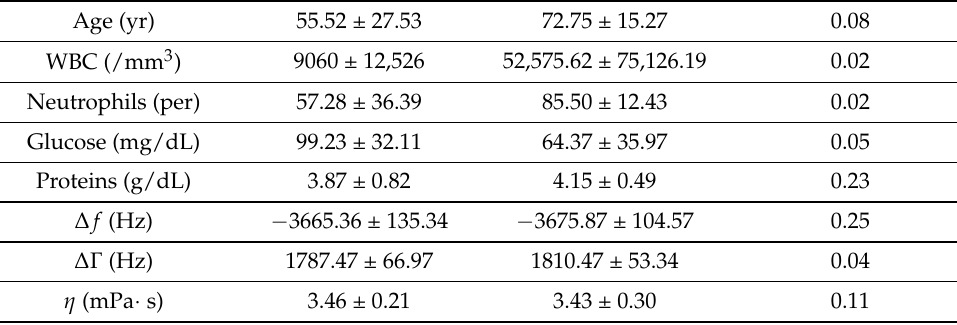
Table 3. Comparison between mean values for SF contained in tubes with